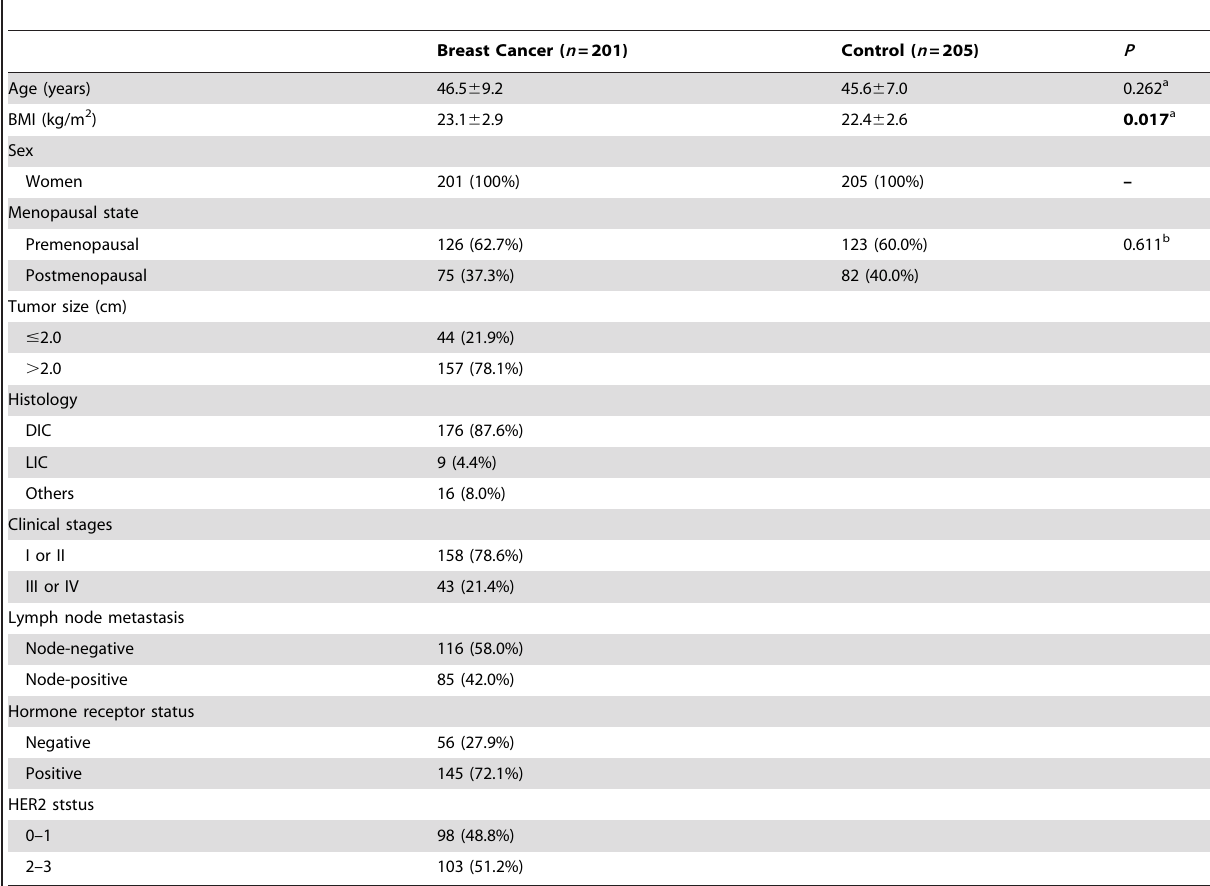
Table 1. Characteristics of breast cancer patients and control